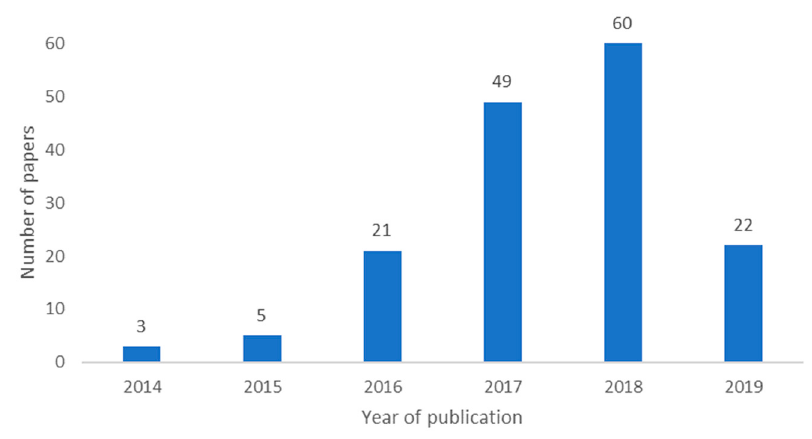
Figure 2. Number of published papers presenting IoT systems for irrigation per year.